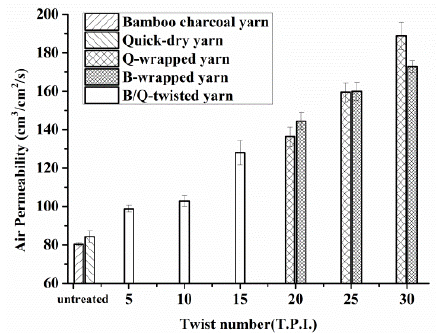
Figure 11. Air permeability of functional elastic knits in relation to the administration of a wrapping/twisting process as well as the t wist n umber of the yarns. The error bar indicates the SD. 3.5. Effects of Twist Number on the Water Vapor Transmission Rate of Functional Elastic Knits